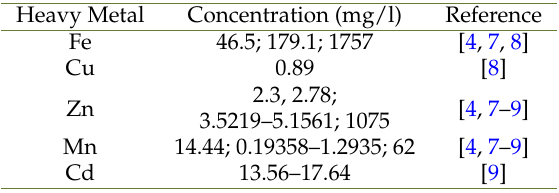
Table 1. Common heavy metals present in